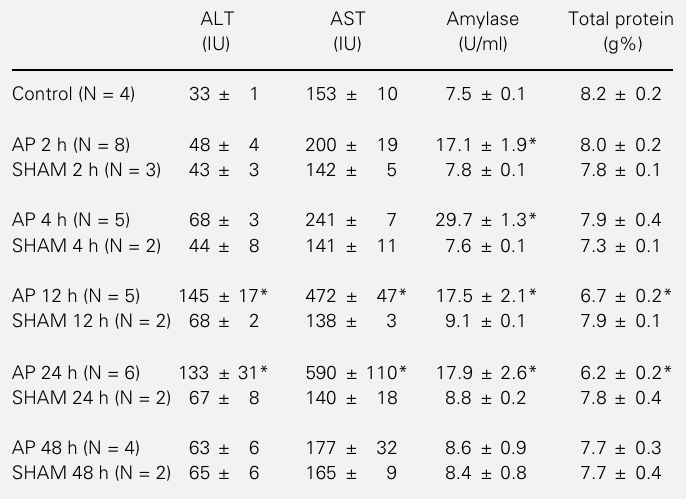
Table 1 - Changes in serum alanine aminotransferase (ALT), aspartate ami- notransferase (AST), amylase and total protein in experimental acute pancreati- tis